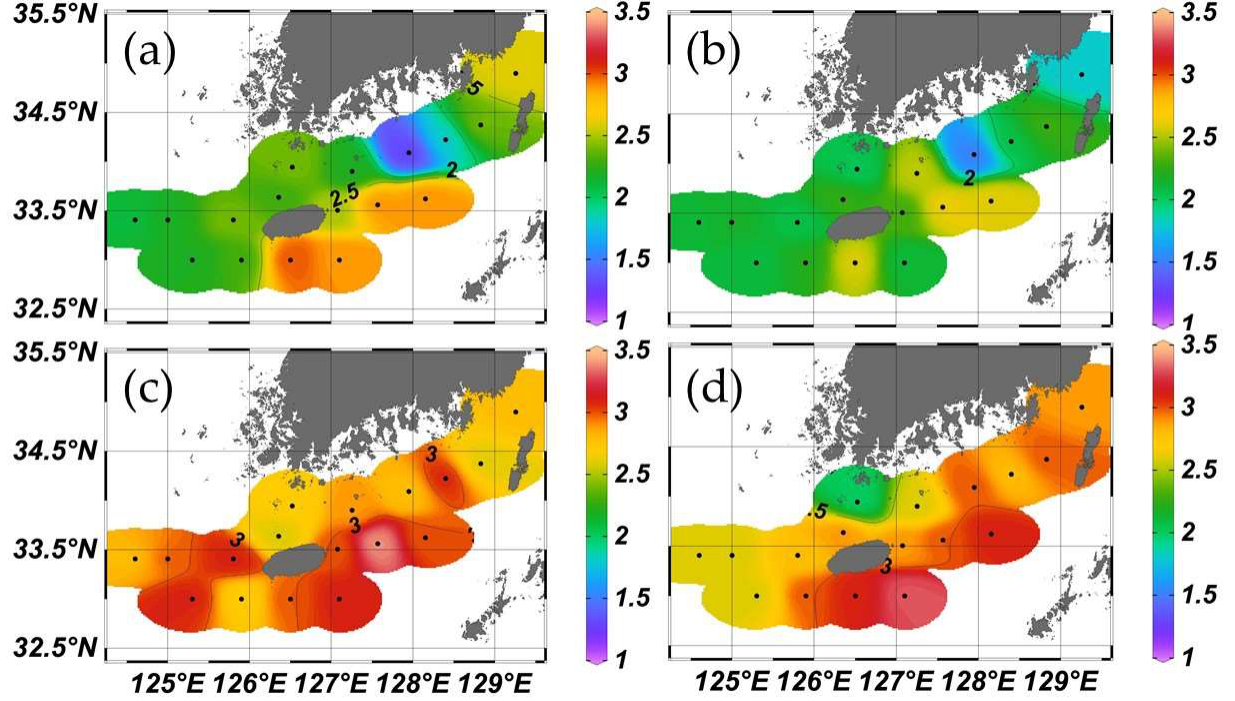
Figure 4. Distribution of copepod abundance (ind m −3 ) at each station in ( a ) February, ( b ) April, ( c ) August, and ( d ) October 2018.